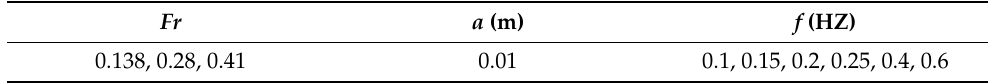
Table 10. Calculation cases of pure pitch motion.